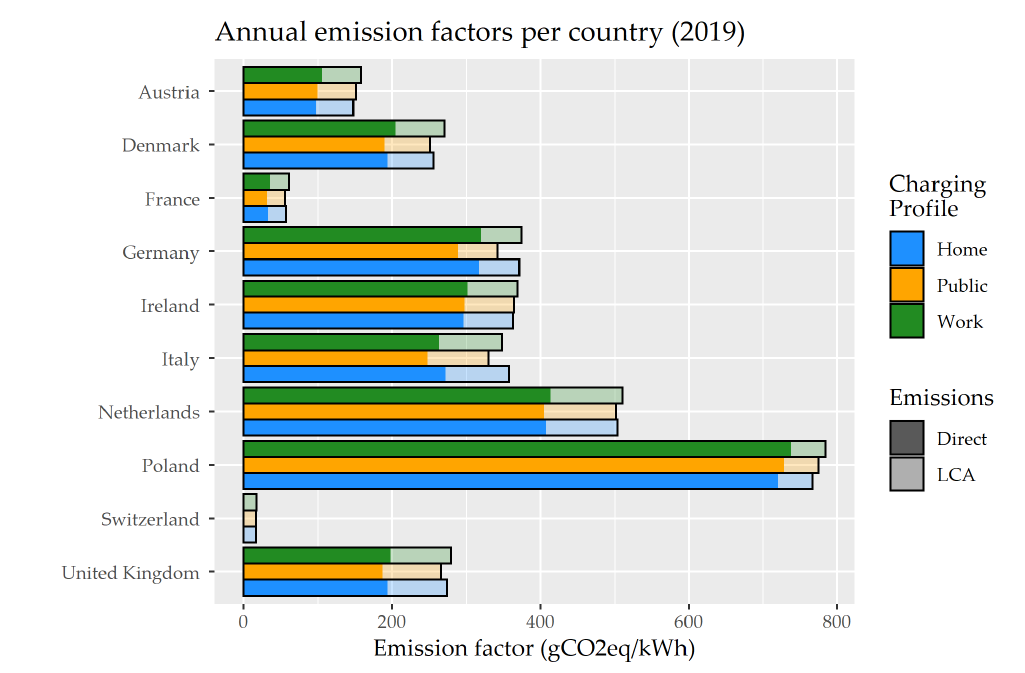
Figure 7. Annual emission factors of EV charging considering different profiles, year